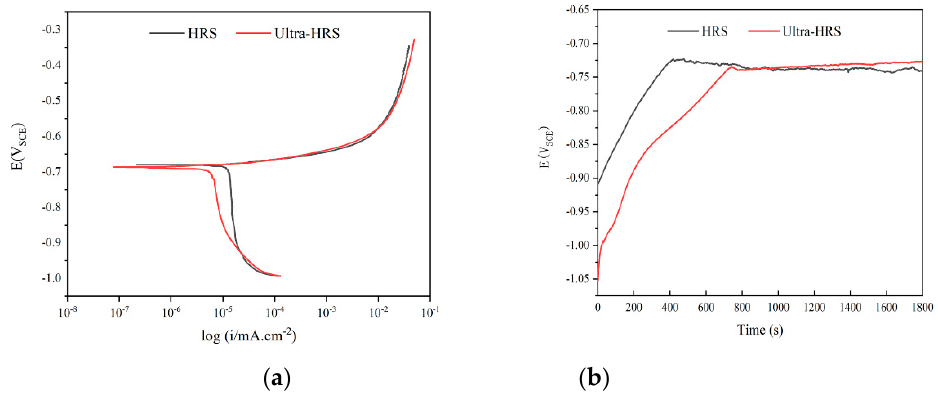
Figure 12. The electrochemical corrosion behavior of HRS and ultra-HRS under low tool offset parameters. ( a ) The open-circuit potential of the connector; ( b ) the polarization curve of the connector.